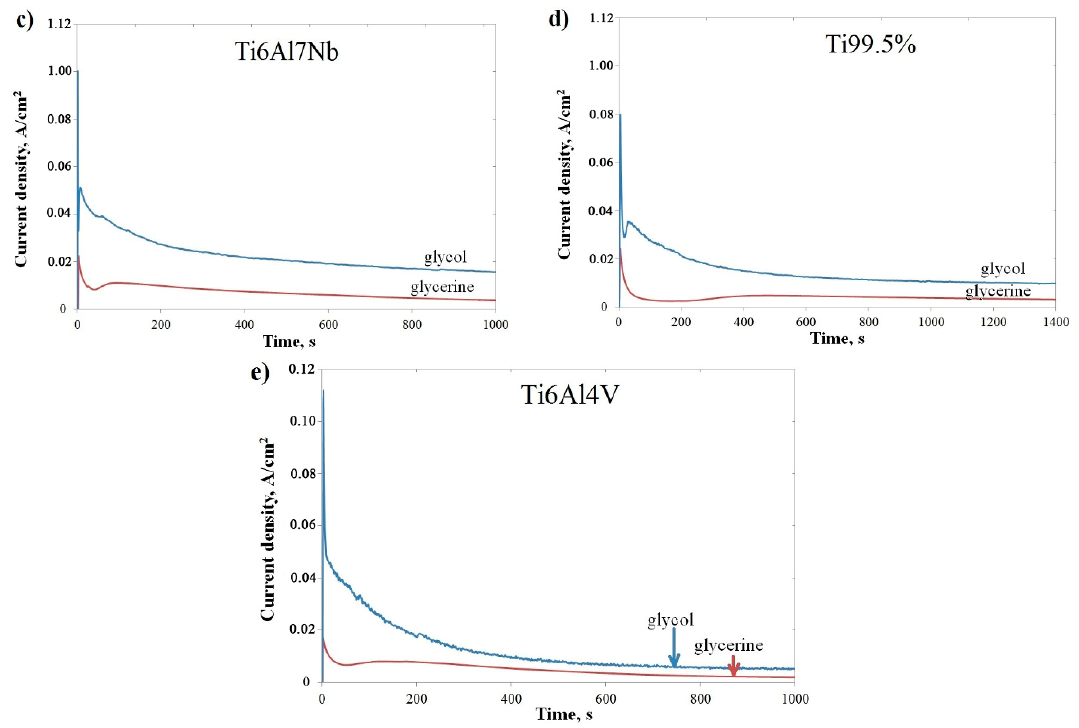
Figure 2. Current density as a function of anodization time (the current curves) for anodization in glycol-based ( a ) and glycerol-based ( b ) electrolyte. The current curves for individual alloy compositions: Ti6Al7Nb ( c ), Ti 99.5% ( d ), and Ti6Al4V ( e ). Table 1. Maximum and average current density, and titanium anodic oxide morphological features depending of the substrate and electrolyte composition.